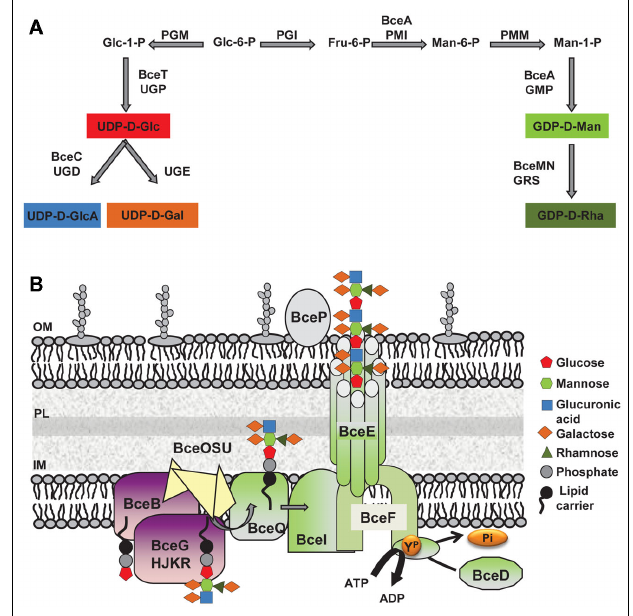
FIGURE 2 | Biosynthesis of the exopolysaccharide cepacian by Burkholderia . (A) Metabolic route toward the synthesis of the various activated sugar-nucleotide precursors required for cepacian repeat-unit biosynthesis. (B) Schematic representation of enzymes involved in cepacian biosynthesis. Repeat-units of the polymer are assembled on a isoprenoid lipid carrier, in the cytoplasmic side of inner membrane in a reaction initiated by the BceB enzyme and continued by the other glycosyltransferases BceG, BceH, BceJ, BceK, and BceR and putative acyltransferases BceO, BceS and BceU.The lipid-linked repeat-units are translocated across the inner membrane by the putative BceQ membrane protein. Polymerization occurs at the periplasmic face of the inner membrane and is dependent on another membrane protein, the putative polysaccharide polymerase, BceI.Wzy-dependent polymerization/export requires the activity of the BceF tyrosine kinase. BceD is a protein tyrosine phosphatase enzyme responsible for dephosphorylating BceF. BceE forms a channel structure for export of EPS chains to the outside. BceP, putatively involved in polysaccharide degradation, is depicted as associated to the outer membrane, as one of its possible locations. Glc, glucose; GlcA, glucuronic acid; Gal, galactose; Rha, rhamnose; Man, mannose; Fru, fructose; GDP, guanosine-5 (cid:2) -diphosphate; UDP, uridine-5 (cid:2) -diphosphate; PGM, phosphoglucomutase; UGP, UDP-glucose pyrophosphorylase; UGD, UDP-glucose dehydrogenase; UGE, UDP-glucose epimerase; PGI, phosphoglucose isomerase; PMI, phosphomannose isomerase; PMM, phosphomannomutase; GMP, GDP-D-mannose pyrophosphorylase;